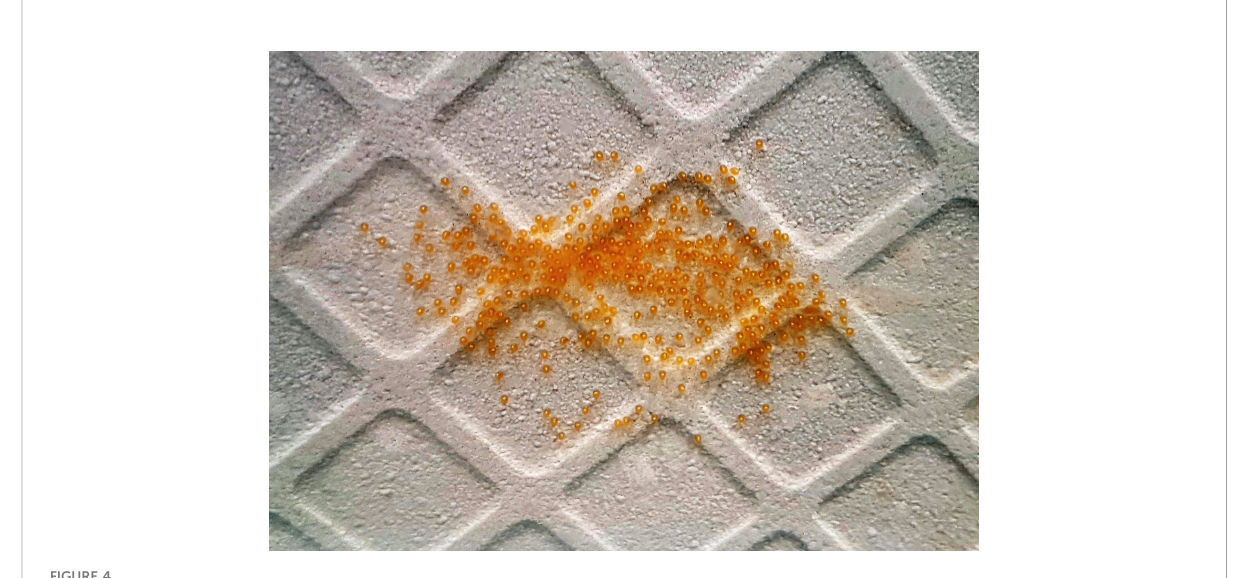
FIGURE 4 Freshly laid eggs of designer clown fi